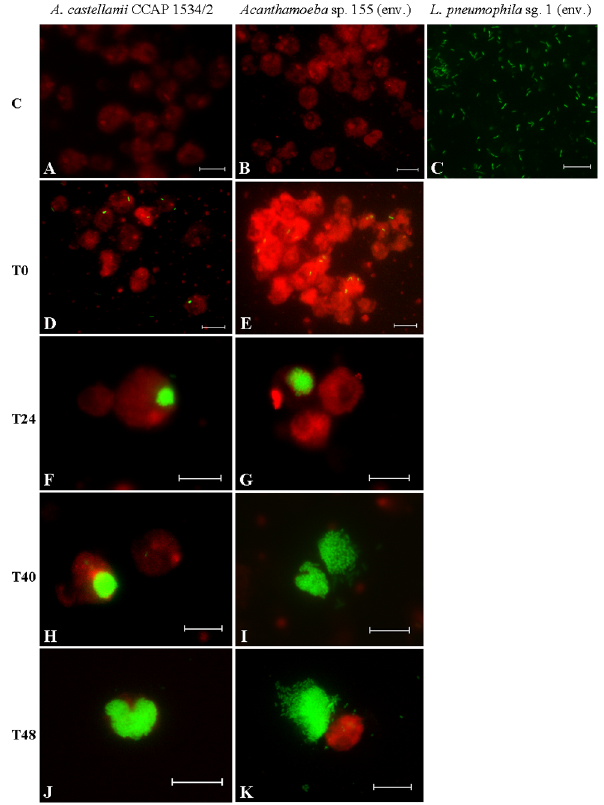
Fig 5. Pictures obtained by FISH using an epifluorescence microscope to monitor the intracellular presence of L . pneumophila sg. 1 (env.) within the two amoeba strains, A . castellanii CCAP 1534/2 (first column) and Acanthamoeba sp. 155 (env.) (second column). Negative controls of pure cultures are shown in the first line ( A , B and C ). Then, the presence of L . pneumophila was analysed at different time points: just after the co-culture protocol ( T0 ) and after 24 h, 40 h and 48 h ( T24 , T40 and T48 , respectively). All samples, including the controls, were simultaneously hybridized with the LEGPNE1 probe (FITC, green) and the probe EUK 516 (Cy3, red). Pictures were taken at 1000X magnification, bar scale = 9.2 µ